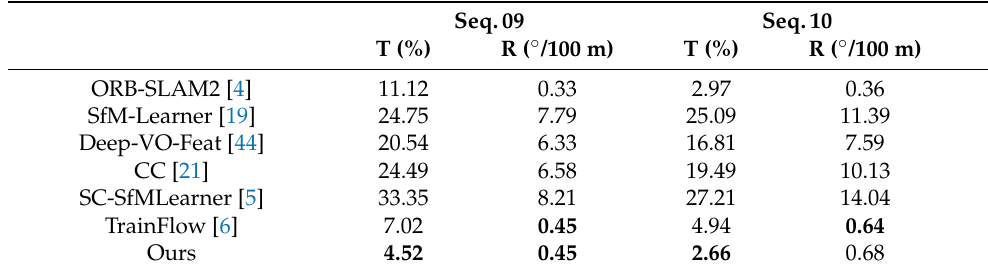
Table 3. The VO results on small-amplitude-motion scene (stride = 2). R ( ◦ /100 m) and T (%) refer to the rotation error and the average translation